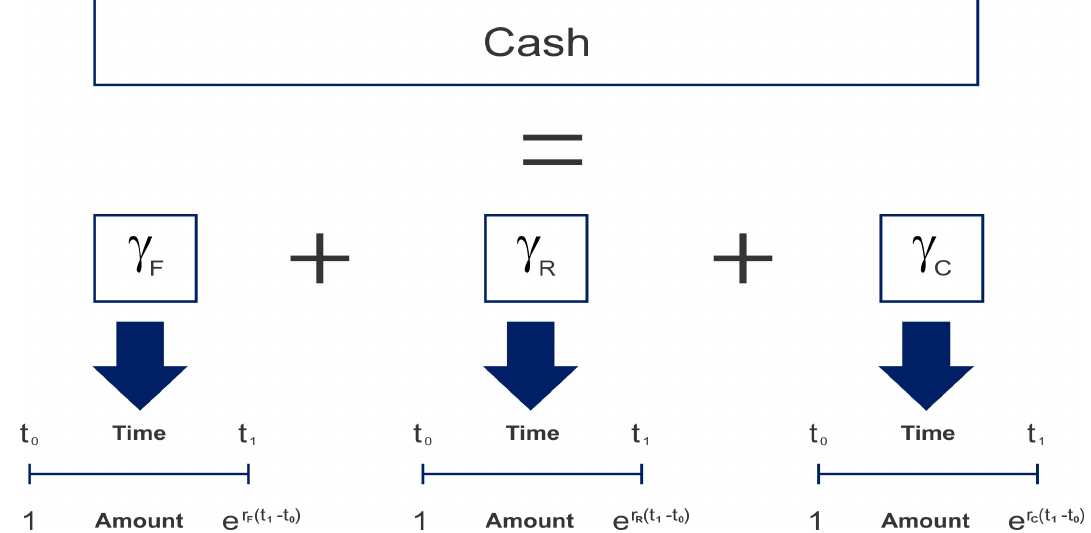
Figure 1. Illustration of the various accounts making up the cash account and the rates payable/earned on